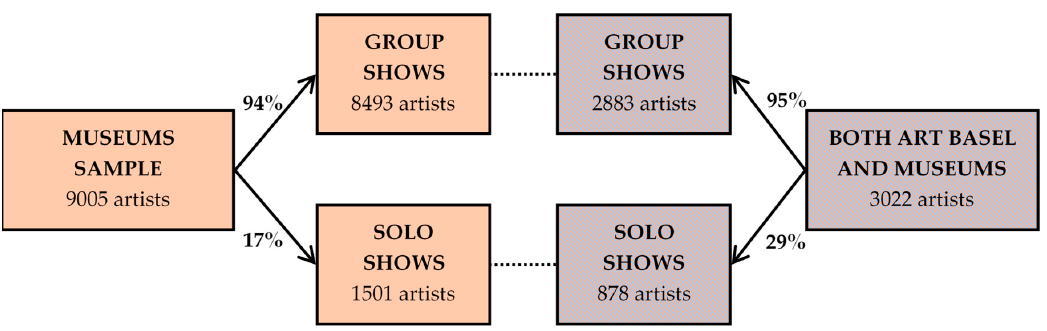
Figure 4. Solo and group shows: Museums and Basel.